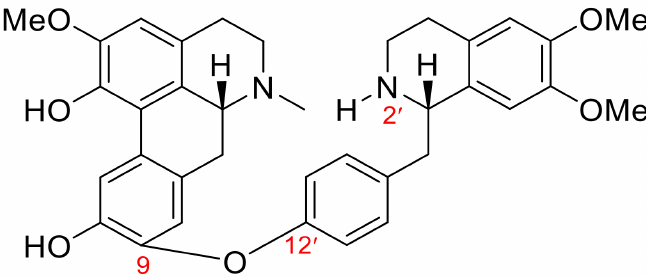
Figure 9. Structure of (+)-2 (cid:48) -norpakistanine ( 108 ).